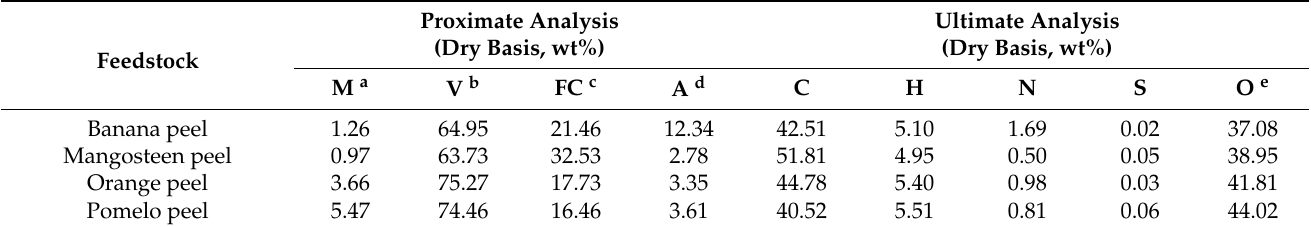
Table 1. Proximate and ultimate analysis results of four waste biomasses. Proximate Analysis (Dry Basis, Feedstock